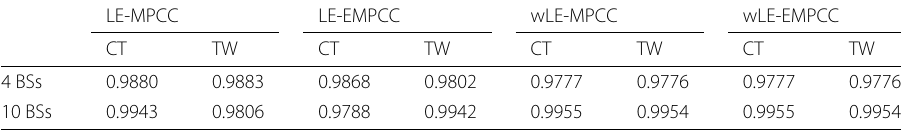
Table 3 Comparison of MPCC and EMPCC in terms of TW and CT measures considering 50 neighbors, weighted LE (w-LE) with T = 0.05 is considered LE-MPCC LE-EMPCC wLE-MPCC wLE-EMPCC CT TW CT TW CT TW CT TW 4 BSs 0.9880 0.9883 0.9868 0.9802 0.9777 0.9776 0.9777 0.9776 10 BSs 0.9943 0.9806 0.9788 0.9942 0.9955 0.9954 0.9955 0.9954